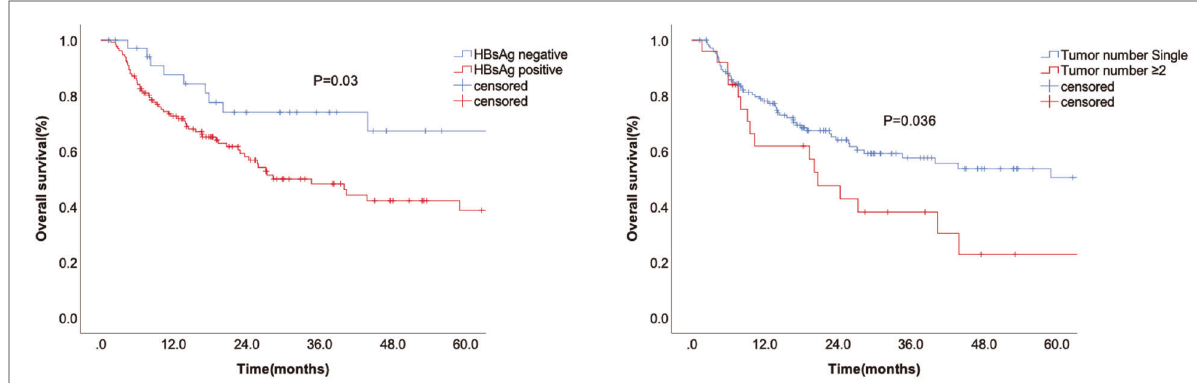
FIGURE 3 The overall survival according to HBsAg and tumor number.